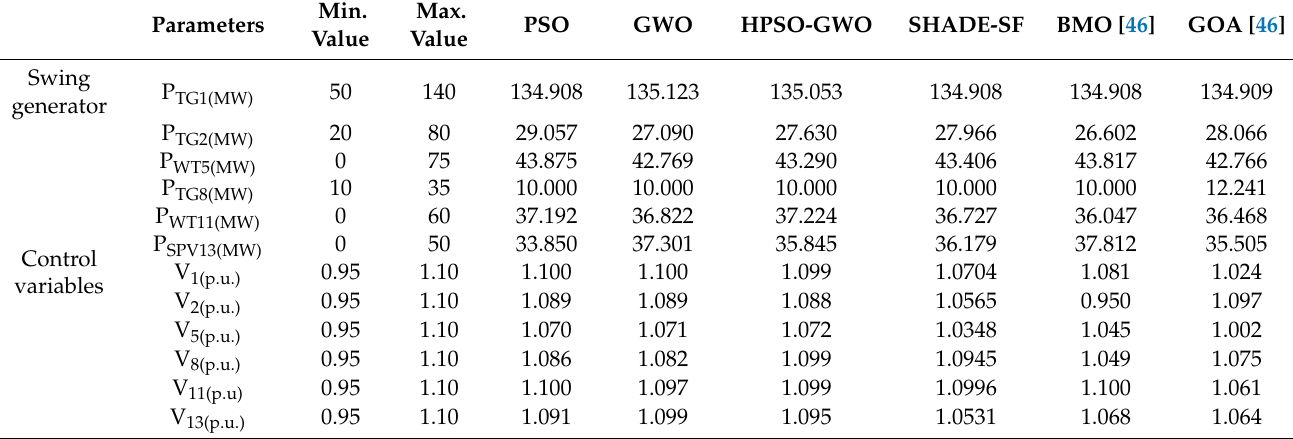
Table 6. Simulation results for Case